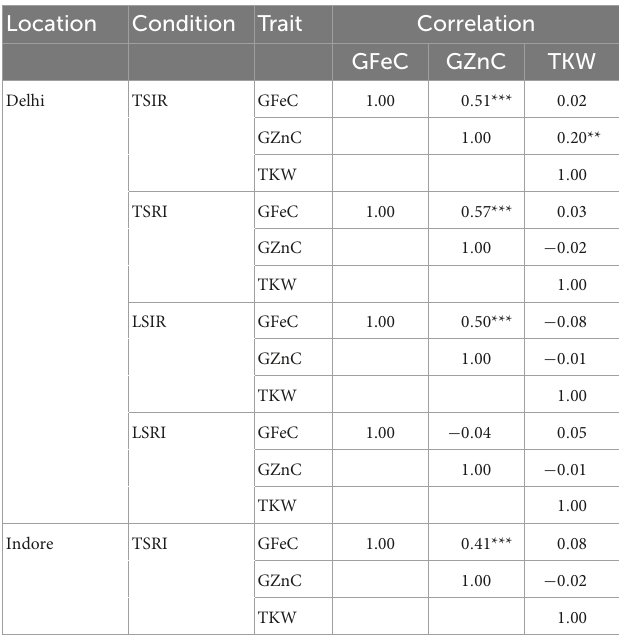
TABLE 5 Distribution of markers and marker density across chromosomes in the linkage map developed in RILs of HD3086/HI1500.